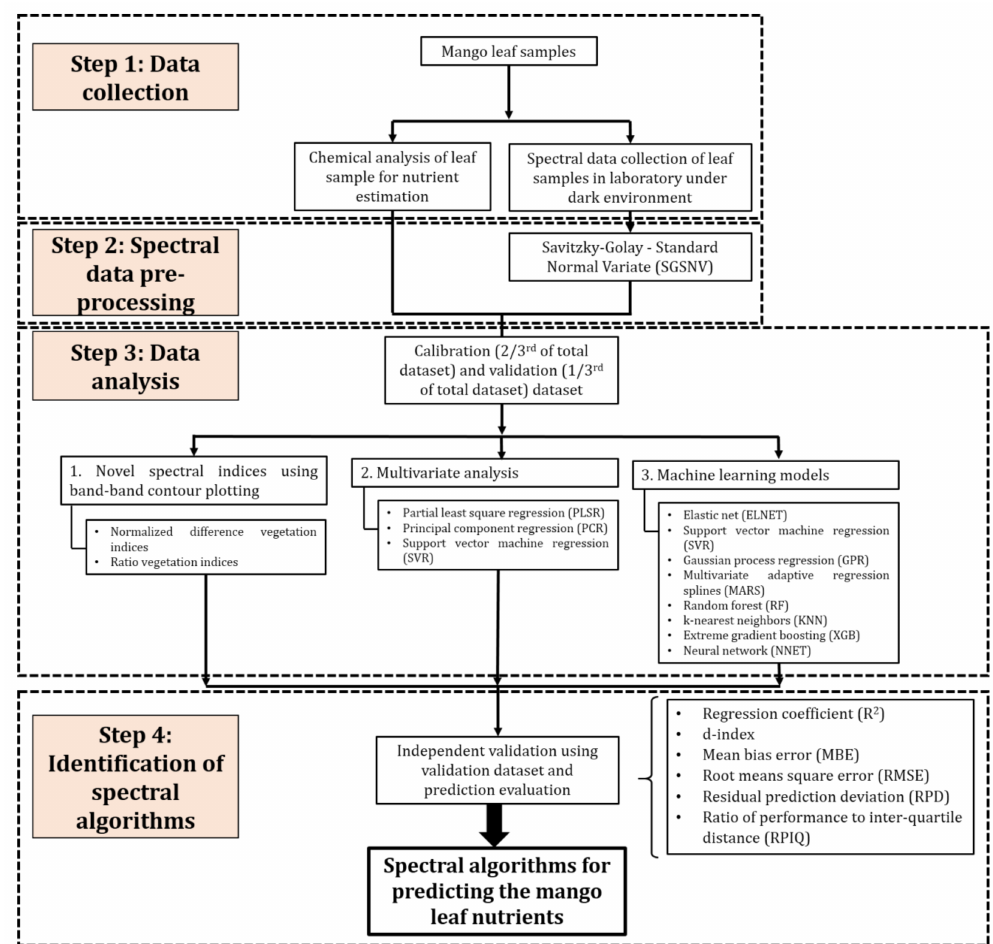
Figure 1. The scheme of the methodology followed in the